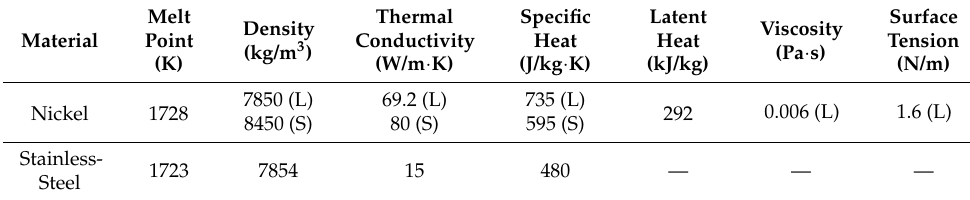
Table 1. Physical properties of Ni and stainless steel (L: Liquid and S: